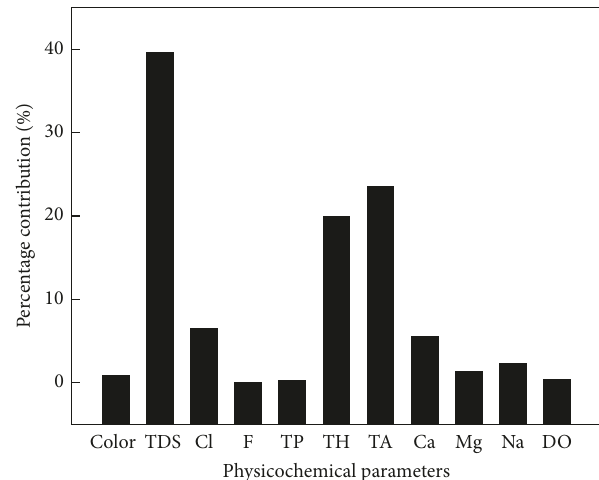
Figure 4: Percentage contribution of various parameters on the electrical